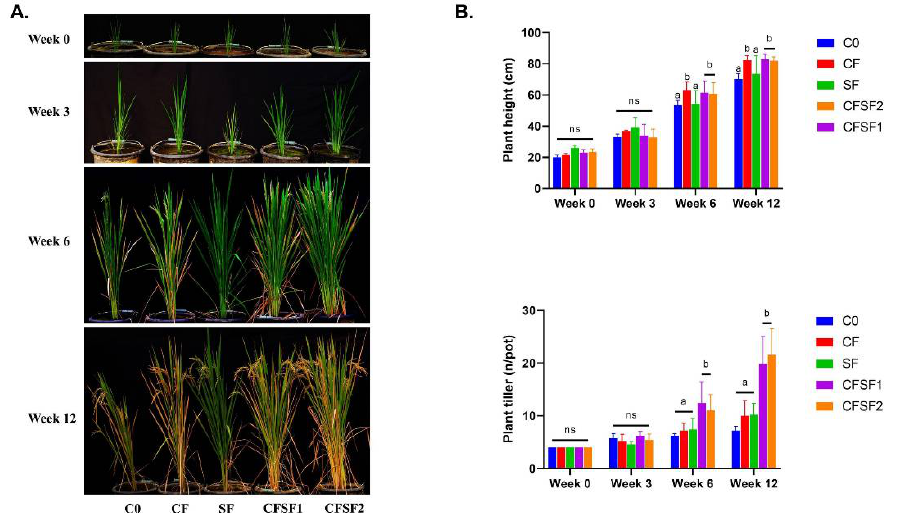
Figure 1. The effects of SF on paddy plant growth. ( A ). Documentation was undertaken to record plant growth dynamics. ( B ). Plant height and number of tillers from week 0 to week 12 before harvest. ns indicates no significant difference ( p < 0.01) between groups in the same week. Different annotation letters indicate significant difference ( p < 0.01) between groups in the same